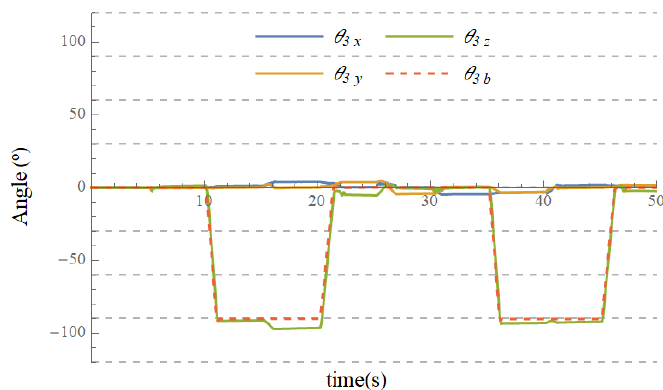
Figure 7. Evolution of Rotation Vector 3 when testing the link model using only gyroscope measurements.